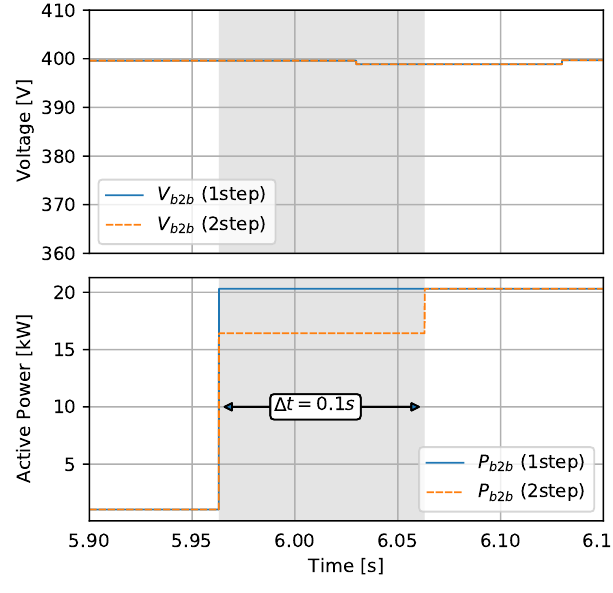
Figure 11. Open-loop DL